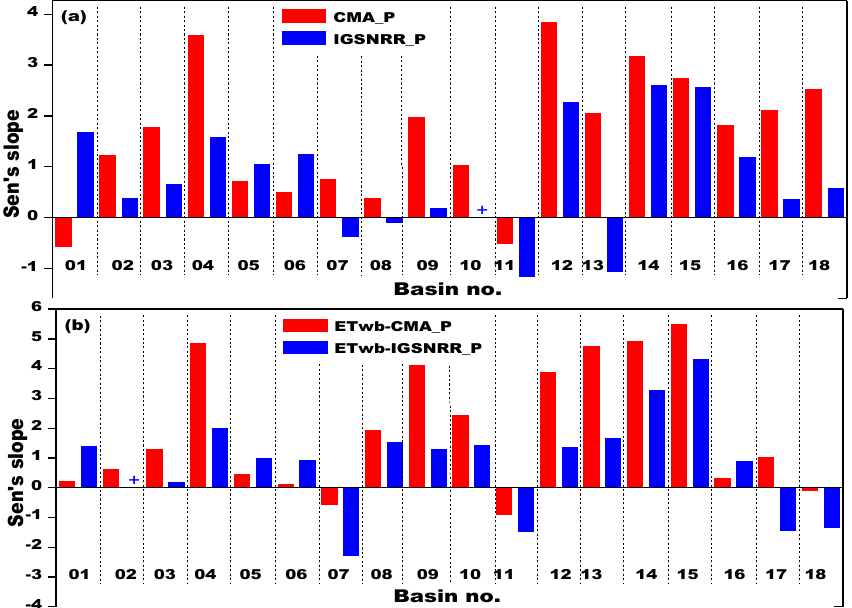
Figure 13. Uncertainties in annual trends of ET wb (b) calculated from two precipitation products (CMA gridded and IGSNRR_Forcing) (a) in 18 TP basins. The comparisons were conducted during the period 1982–2011 (TRMM data were not available for the whole